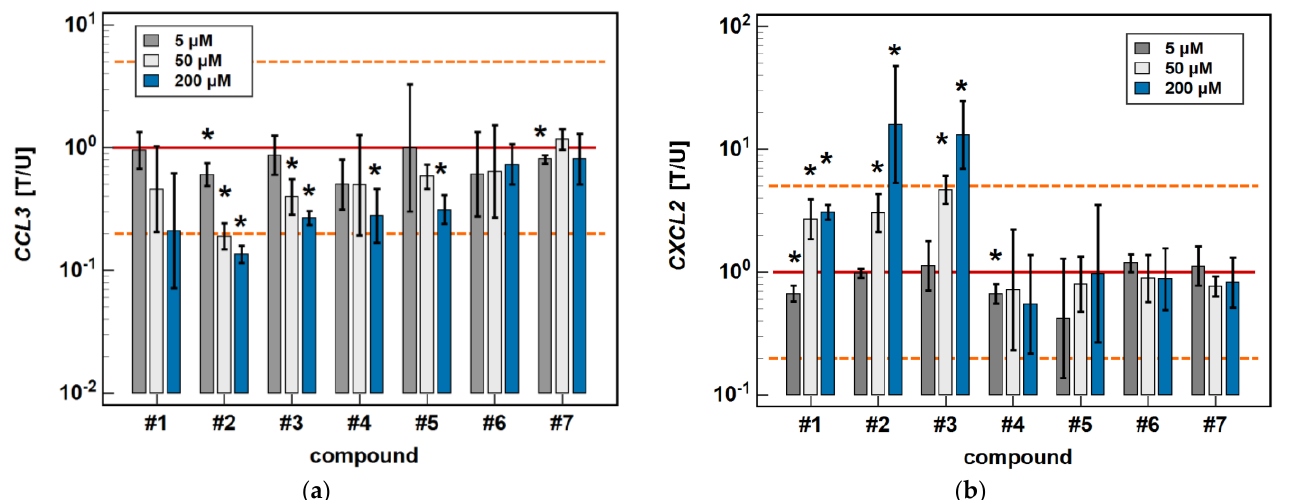
Figure 6. Dose-dependent effect of oxicams on MCP and MIP expression in HCT 116 cells: ( a ) CCL3 ; ( b ) CXCL2 . The bars and whiskers represent the mean ± SD expression ratio of the normalized relative quantities [NRQ] obtained for cells treated with 5, 50, and 200 μM oxicams for 24 h, and the corresponding untreated controls (treated-to-untreated [T/U] ratio). The significant differences between the expression in treated and untreated cells, analyzed using a t -test for paired samples, are indicated by asterisks (*). No fold-change (T/U = 1) is indicated by a red solid reference line, and five-fold upregulation (T/U = 5) or downregulation (T/U = 0.2) is indicated by an orange dashed reference line. Compound # 6 denotes piroxicam, and # 7 denotes meloxicam.